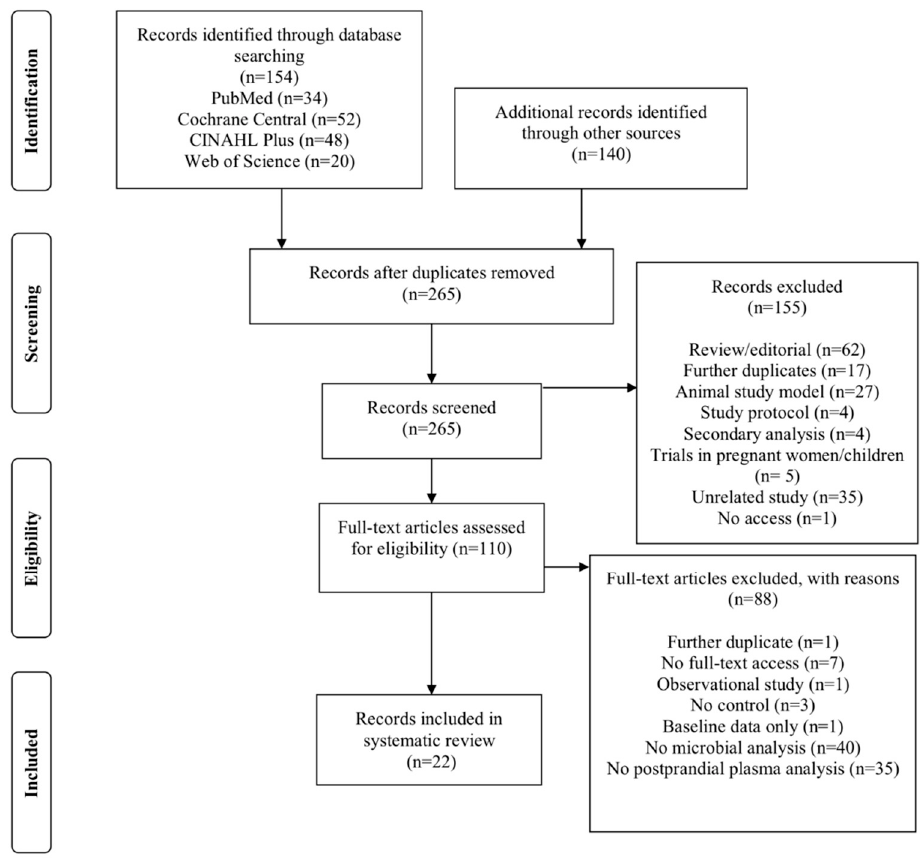
Figure 1. PRISMA flowchart illustrating the screening and selection process.